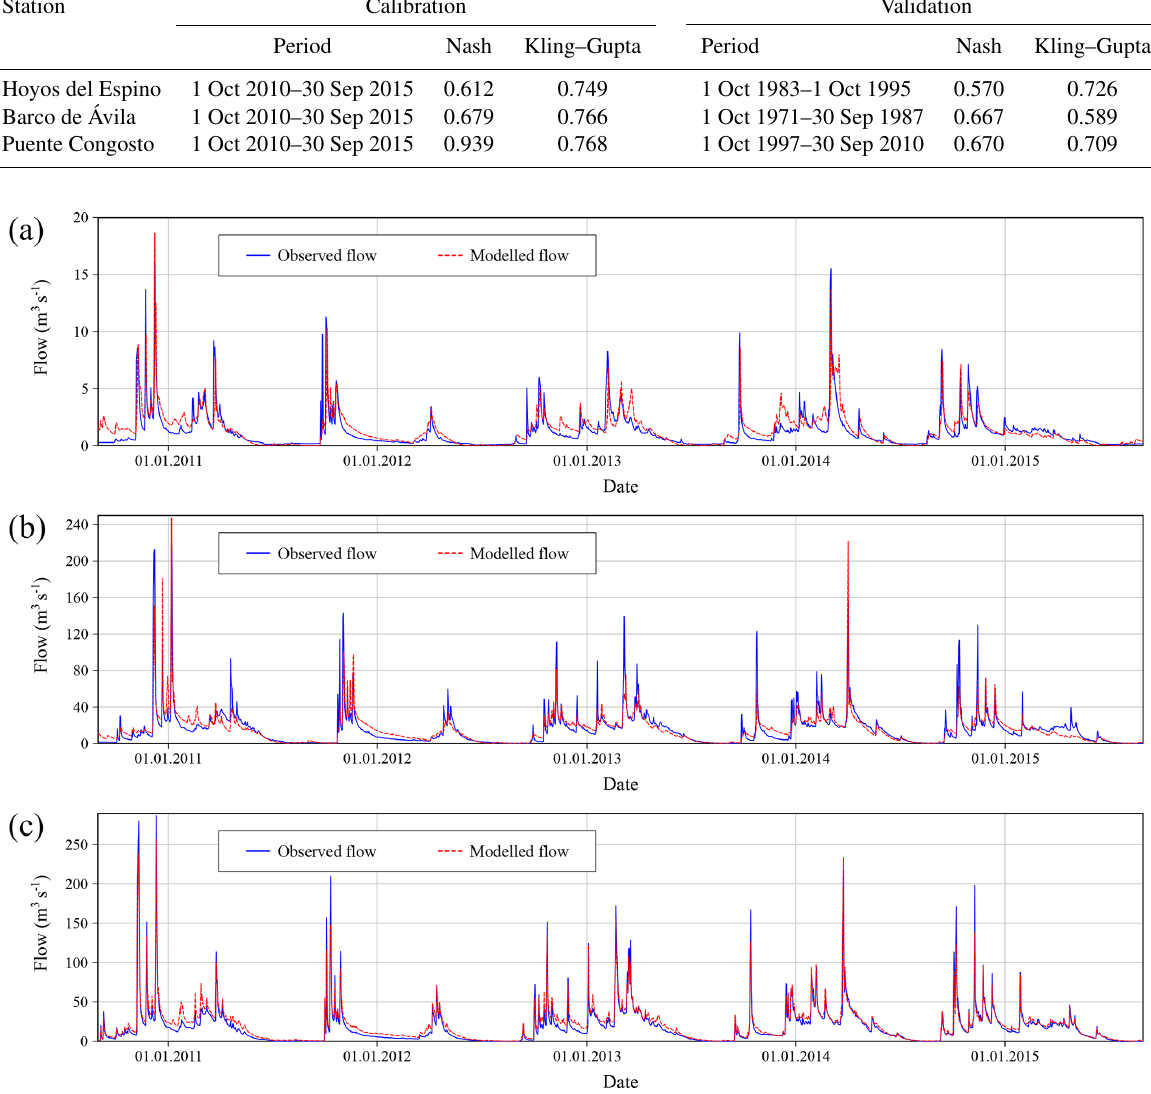
Figure 6. Comparison between observed (blue) and modelled (red) flows for the gauging stations (a) Hoyos del Espino, (b) Barco de Ávila and (c) Puente